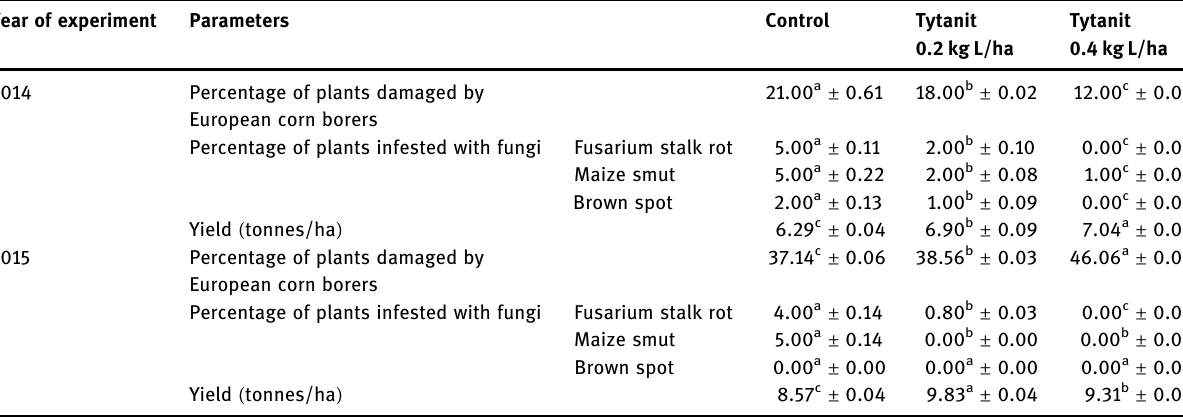
Table 4: The results of experiments on maize. Mean values ± standard deviations Year of